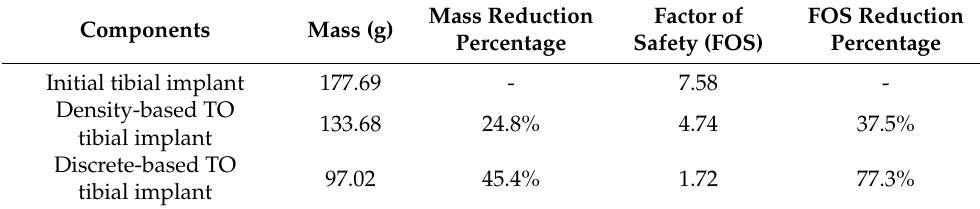
Table 3. Evaluation of the initial and TO tibial implants. Mass Reduction Factor of FOS Reduction Components Mass (g) Percentage Safety (FOS) Percentage Initial tibial implant 177.69 - 7.58 - Density-based TO 133.68 24.8% 4.74 37.5% tibial implant Discrete-based TO 97.02 45.4% 1.72 tibial implant